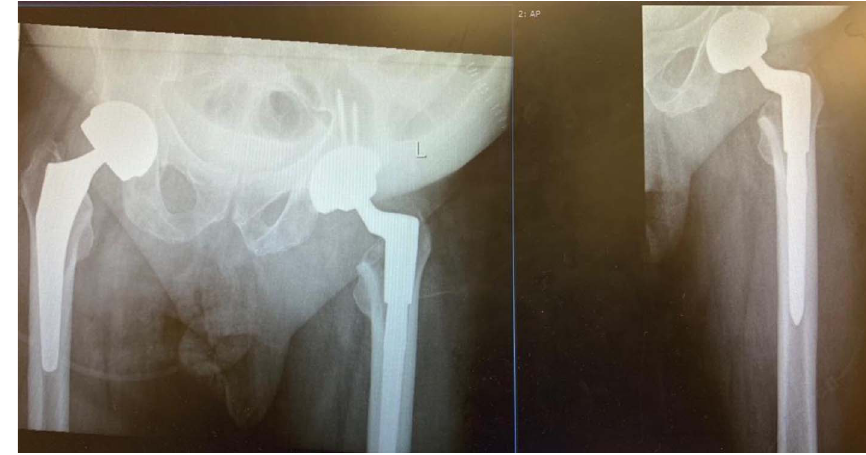
Figure 4. AP pelvis and left hip post-operative check